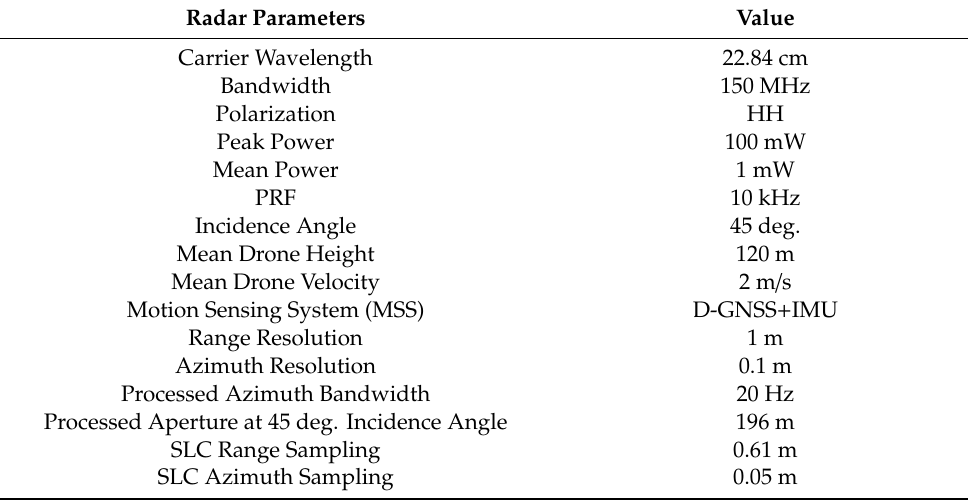
Table 1. Main radar acquisition parameters.